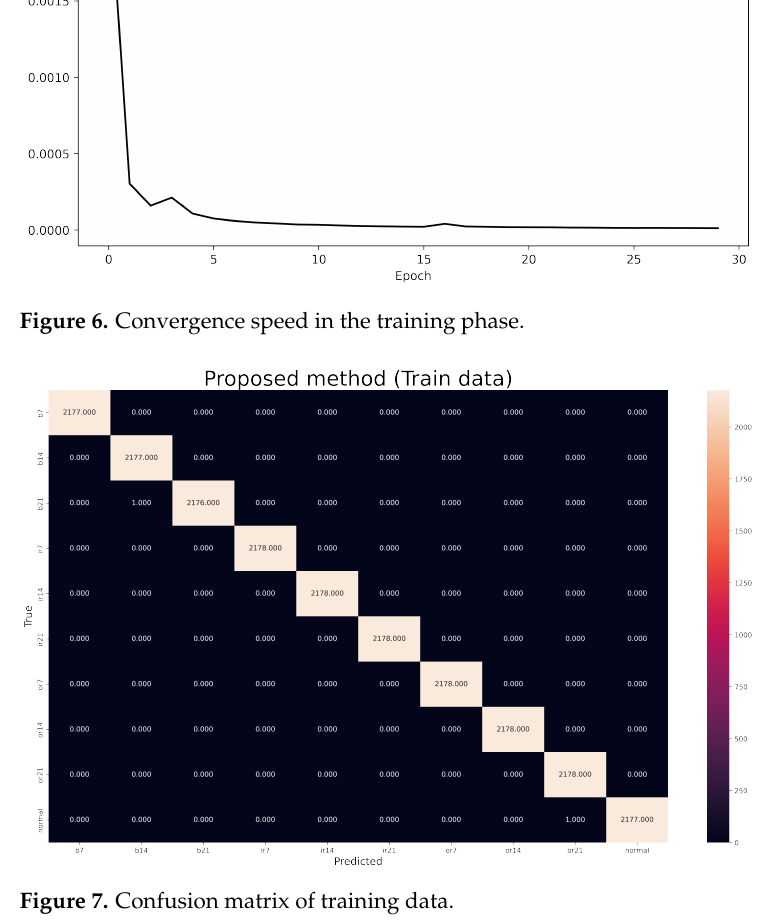
Figure 7. Confusion matrix of training data.